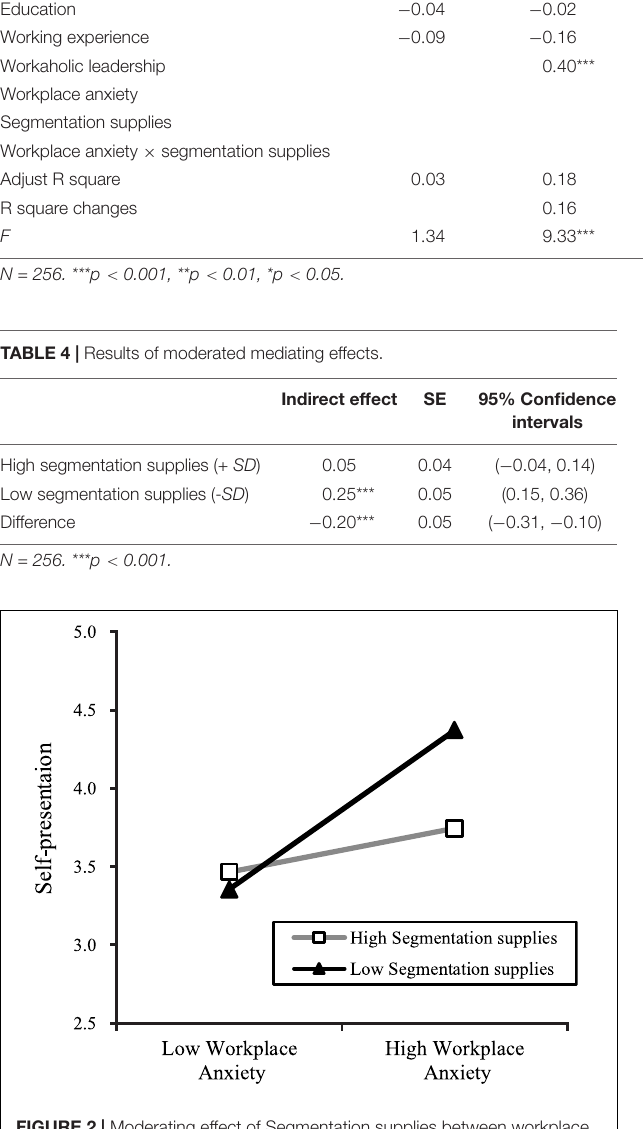
FIGURE 2 | Moderating effect of Segmentation supplies between workplace anxiety and